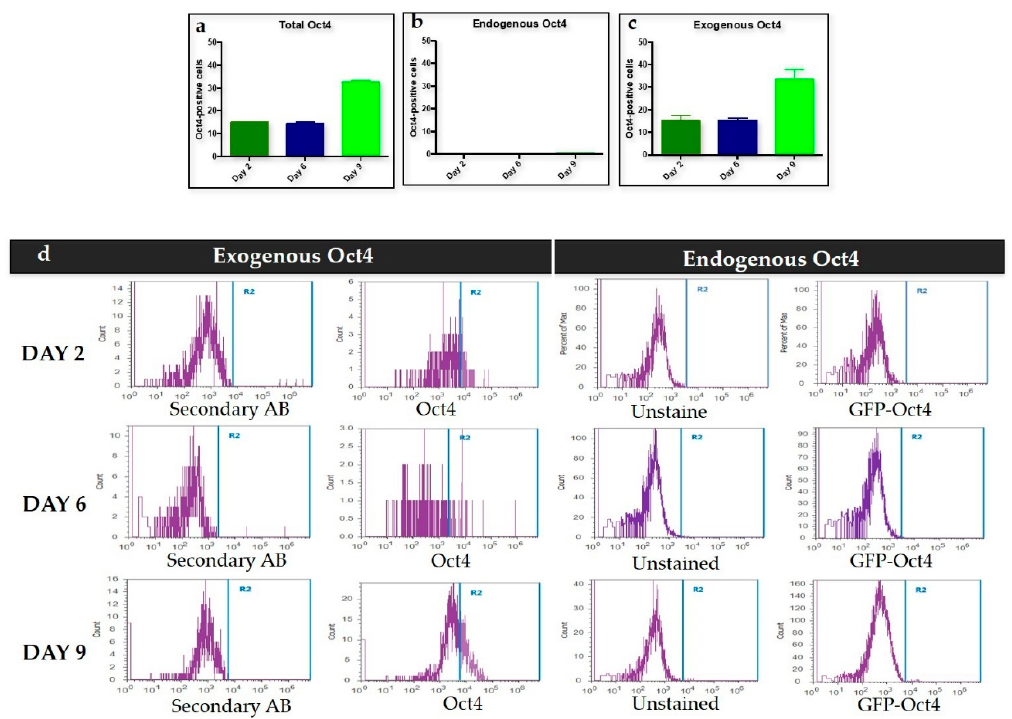
Figure 2. Exogenous, but not endogenous Oct4 expression during the first stage of trans- differentiation. The figure shows ( a ) the total signal of Oct4 (exogenous and endogenous) at every time point, and ( b ) no endogenous Oct4 at any time point. ( c ) Exogenous Oct4 signal was present since day 2 with the highest signal shown at day 9 indicating that partial reprogramming is occurring. ( d ) Histogram demonstrating the log change in exogenous Oct4 compared to the absence of log change in endogenous Oct4 . The absence of log change on endogenous Oct4 and the log change on exogenous Oct4 demonstrated the absence of iPSCs formation.